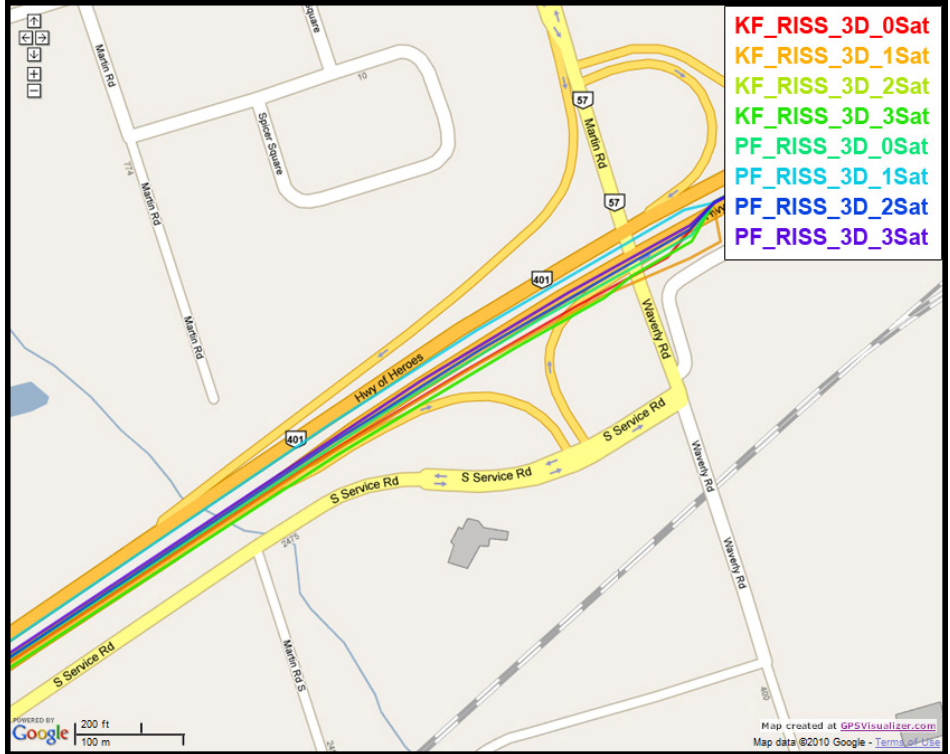
Figure 15. Performance towards the end of the simulated GPS outage #3 of the second